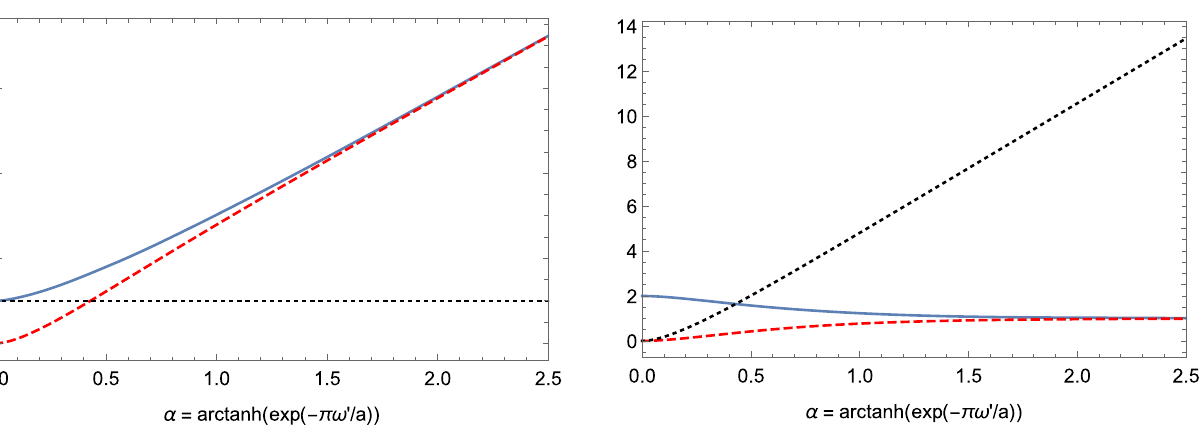
Fig. 2 von Neumann entropies of the states ρ M ,ρ I ,ρ II . The state ρ M is shown by the black (dotted) line, ρ I by the blue (solid) line and ρ II by the red (dashed) line